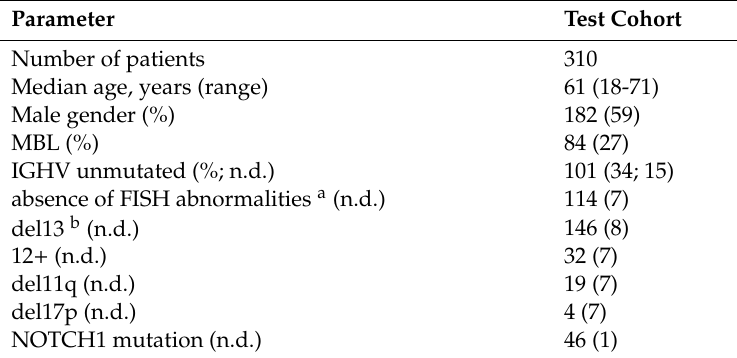
Table 1. Features of 310 CLL